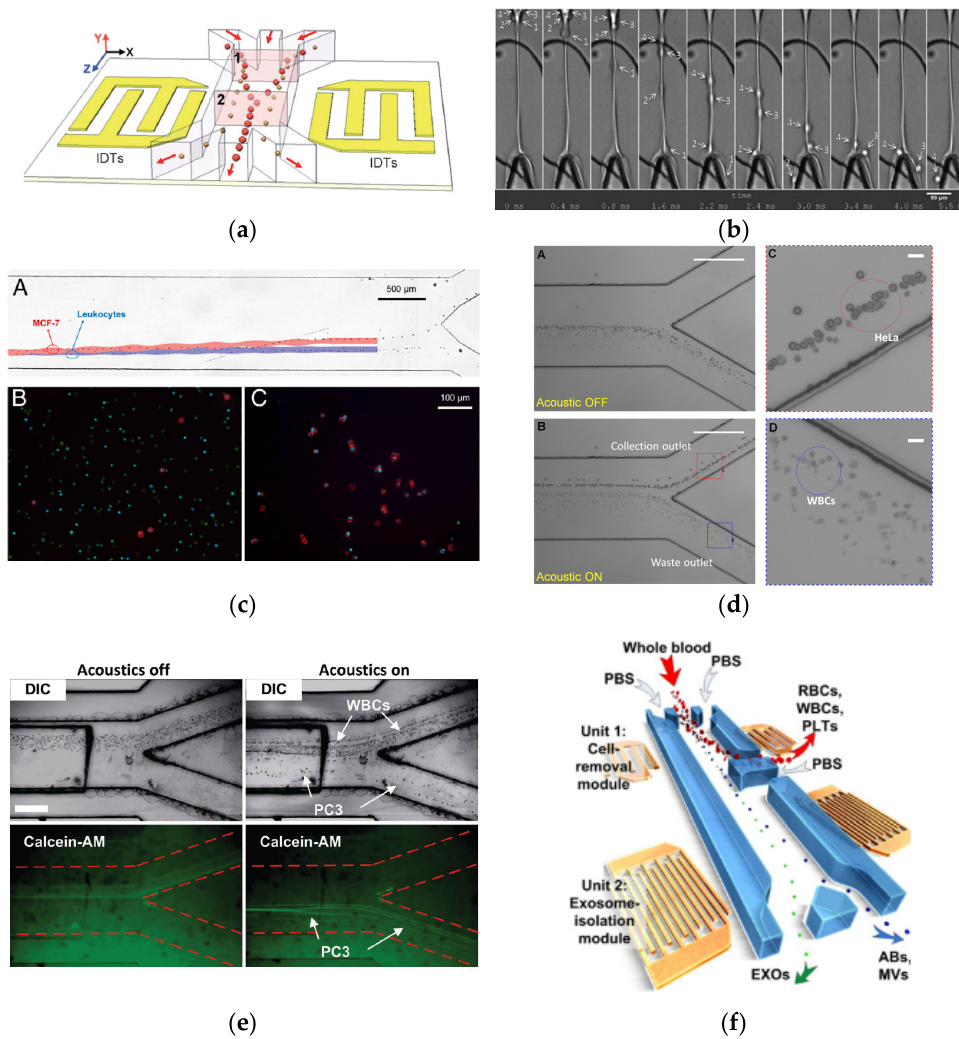
Figure 6. ( a ) Separation process showing larger particles closer to the channel centre and smaller particles further away from the centre [38]. ( b ) MV3 cells enter the different outlet channels at 1 kHz [39]. ( c ) ( A ) Single MCF-7 cell was pulled out from the stream of leukocytes. ( B ) Fluorescent images of cells before separation. ( C ) Fluorescent images of cells after separation [40]. ( d ) ( A ) Acoustic field OFF, no separation was found. ( B ) The acoustic field is ON, larger HeLa cells have been moved to the collection outlet (blue box), whereas smaller WBCs remained in the waster outlet (red box). ( C and D ) Zoomed-in images of the collection outlet and the waste outlet, respectively [41]. ( e ) Separation of 5.84 µm beads (not labelled) and 970 nm (labelled with fluorescent dye) using a taSSAW device (Scale bar: 500 µm) [42]. ( f ) PC3 cells were stained by Calcein-AM and mixed into a 1 mL suspension of WBCs. After the acoustic field was activated, PC3 cells were pushed toward the bottom collection outlet (Scale bar: 400 µm) [43]. Images reproduced with permission from references [38–43].